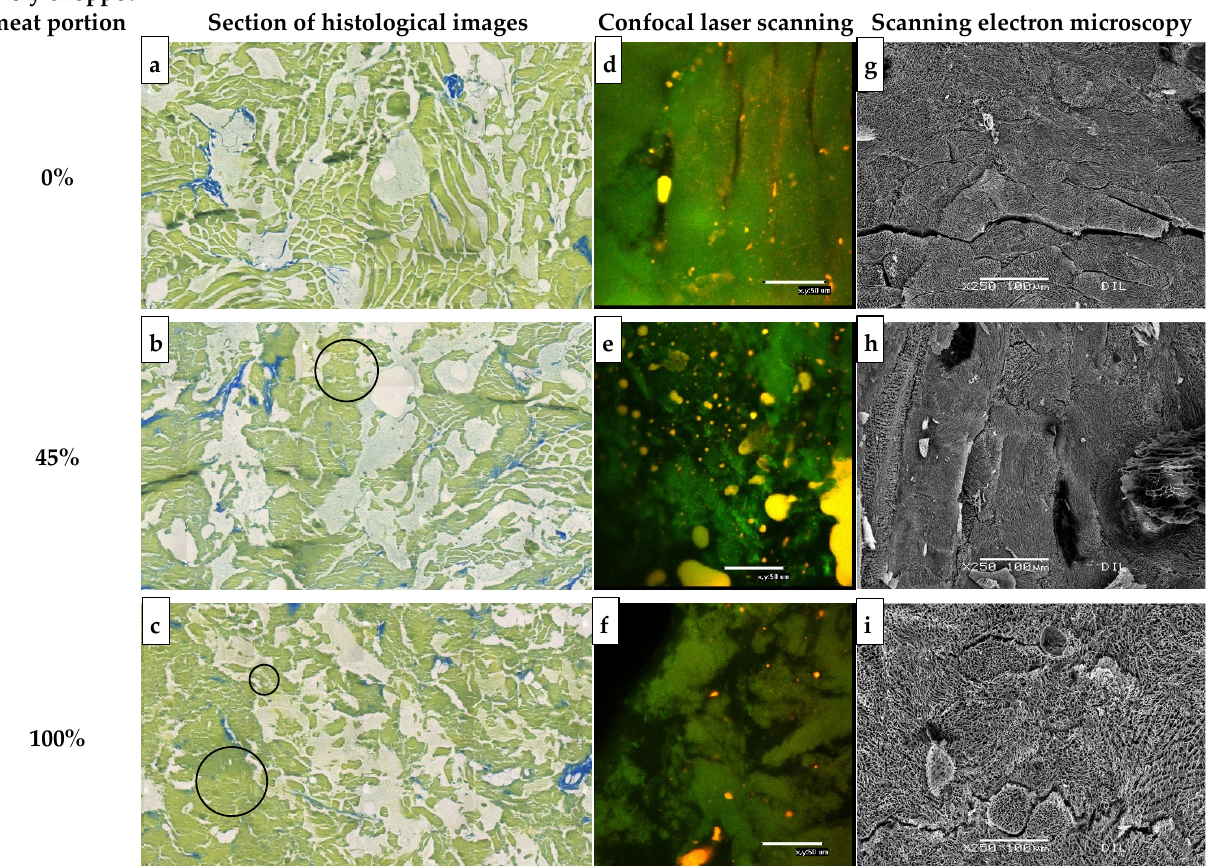
Figure 3. ( a – c ) Typical section of histological images (magnification 100×; green: muscle, blue: fat, white: not colored; encircled: destroyed cells), ( d – f ) confocal laser scanning microscopy (CLSM: magnification 60×, length of bar: 50 µm; green: protein, red: fat) and ( g – i ) scanning electron microscopy (SEM: magnification 250×, length of bar: 100 µm) of raw minced meat with 0, 45, and 100% finely chopped meat added. Histological images do not represent identical samples section as do CLSM and SEM.